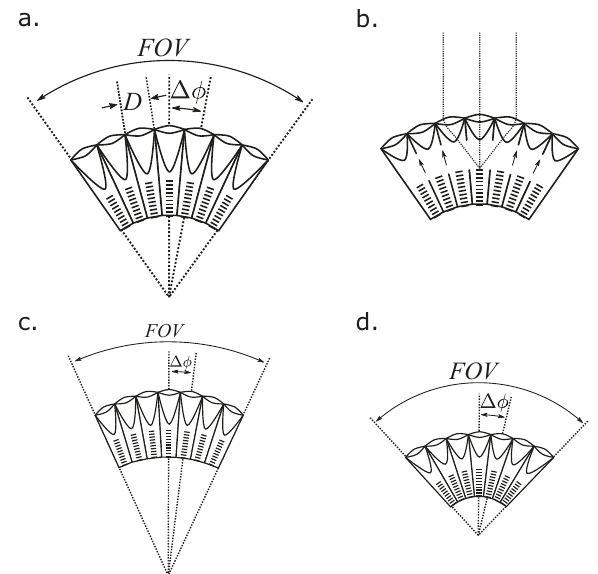
Fig. 1 Geometric tradeoffs between lens diameter ( D ), interommatidial angle ( Δφ ), and fi eld of view ( FOV ). Diagrams of apposition and superposition eyes demonstrating the geometric tradeoffs between D , Δφ , and FOV for spherical (a. and b.) and non-spherical eyes (c. and d.). a In spherical apposition eyes, D directly determines sensitivity while Δ φ inversely determines acuity. b In superposition eyes, migrating pigment (indicated by the arrows) allows the ommatidia to share light, increasing the eye ’ s sensitivity. As a result, these eyes generally adhere to a spherical design. c-d In nonspherical eyes, the intersection of ommatidial axes differs from the center of curvature, with ommatidial axes askew from the surface of the eye. Consequently, FOV and Δ φ are not externally measurable and the effect of D on sensitivity is reduced by greater angles of skewness. c . When the distance to the intersection is greater than the radius of curvature, FOV and Δ φ decrease, increasing average spatial acuity by directing more ommatidia over a smaller total angle. d Inversely, when the distance to the intersection is less than the radius of curvature, FOV and Δ φ increase, decreasing average spatial acuity by directing fewer ommatidia over a smaller total angle. In both cases, optical sensitivity is lost because skewness reduces the effective aperture of the